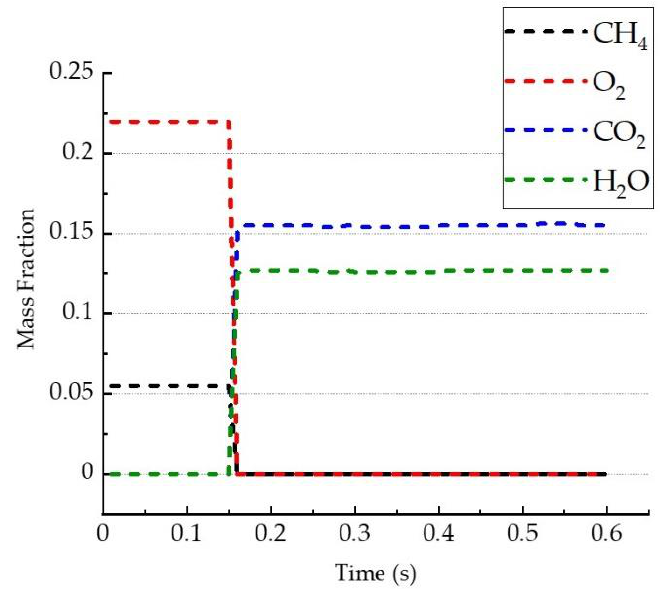
Figure 8. Combustion products mass fraction in the chamber.